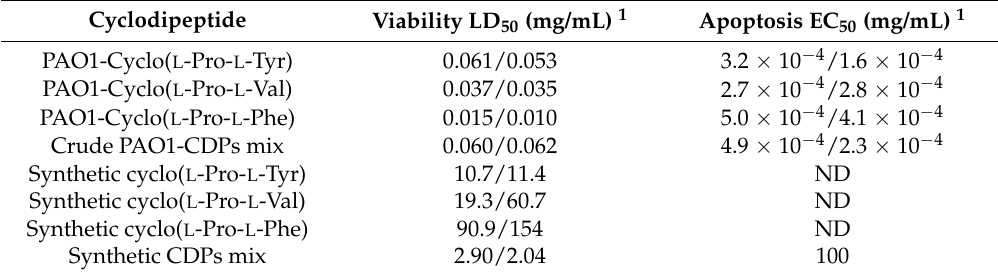
Table 1. Induction of cellular dead and apoptosis on human tumor HeLa cells by the P. aeruginosa PAO1